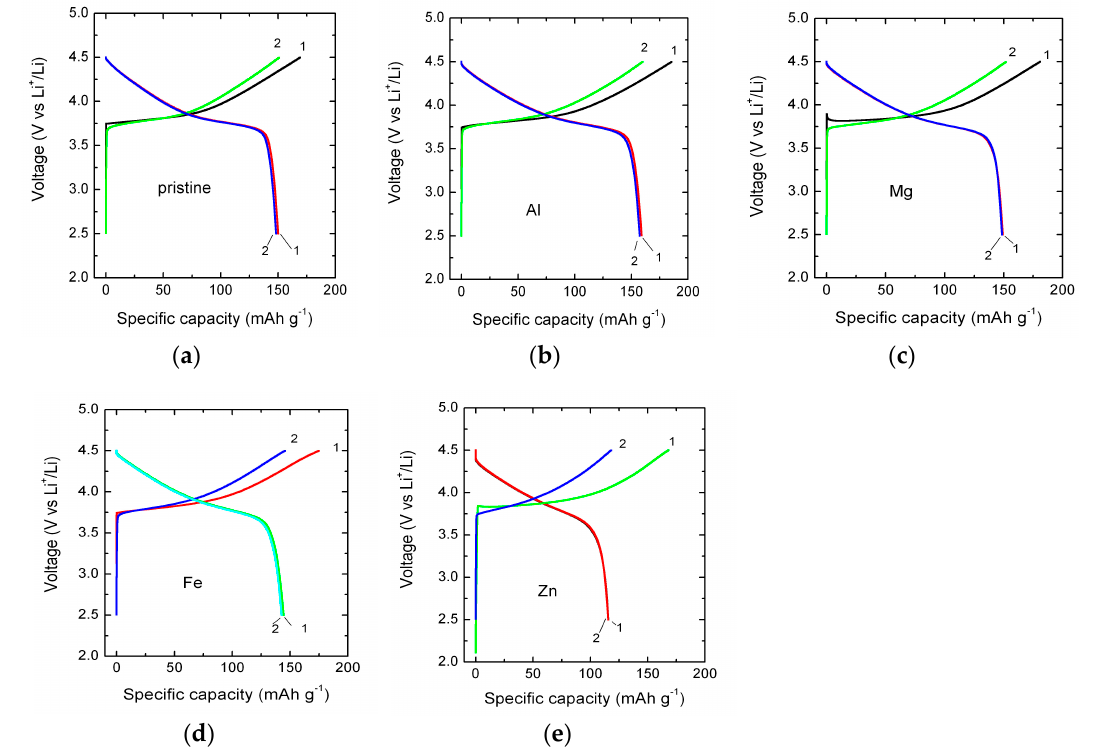
Figure 8. Charge ‐ discharge profiles of pristine ( a ) and doped LiNi 1/3 Mn 1/3 Co 1/3 O 2 with Al ( b ), Mg ( c ), Fe ( d ) and Zn ( e ) carried out at the 0.1C rate in the potential range 2.5–4.5 V versus Li + /Li 0 .